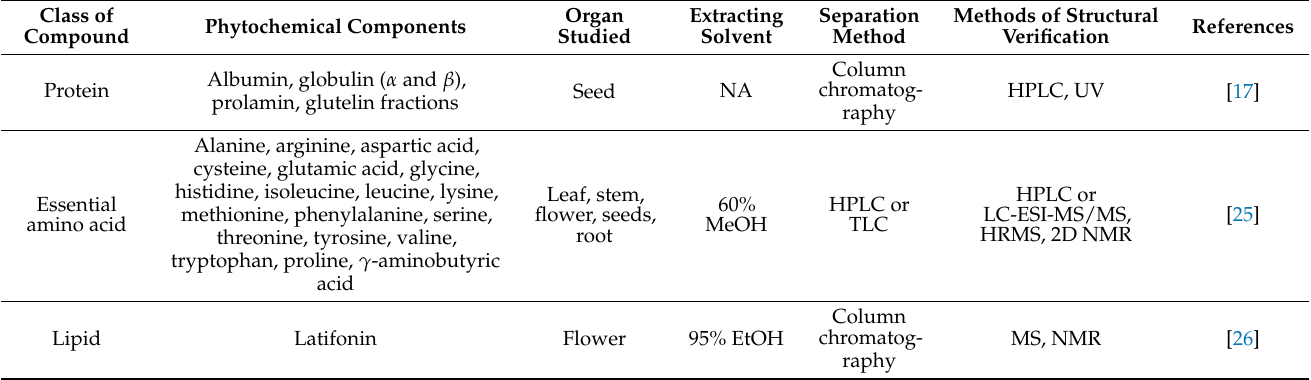
Table 2. Phytochemical components in